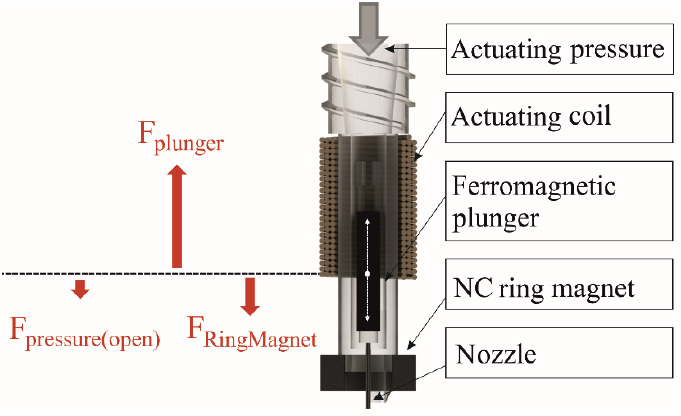
Figure 2. Cross section of the disposable, electromagnetic dispensing valve and the three main forces acting on the ferromagnetic